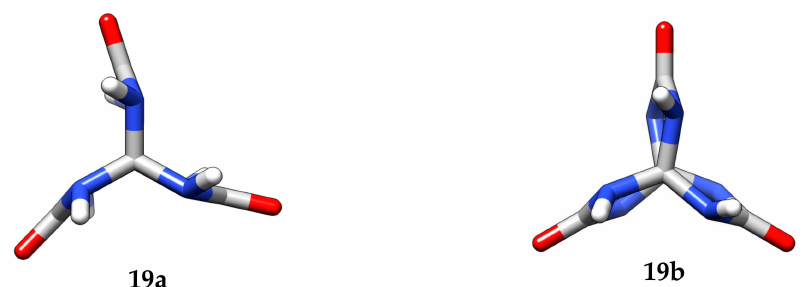
Figure 5. Stable conformers of compound 3,7,10-trioxo-2,4,6,8,9,11-hexaaza[3.3.3]propellane 19 (view along the axis of C 1 -C 5